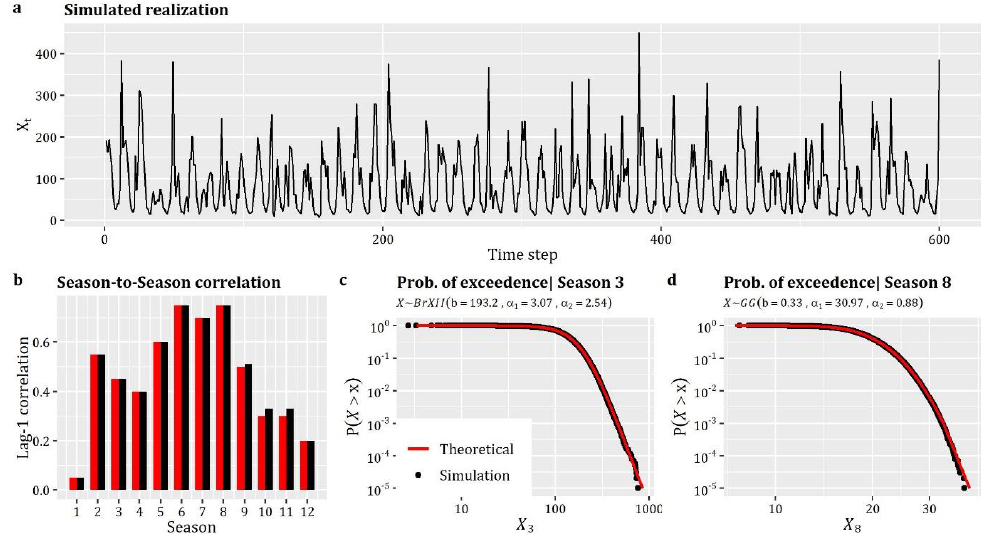
Figure 3. Simulation of univariate cyclostationary processes: ( a ) simulated realization of the process; ( b ) comparison between theoretical and simulated Lag-1 season-to-season correlation coefficients; and ( c , d ) comparison between theoretical and simulated empirical probability plots.